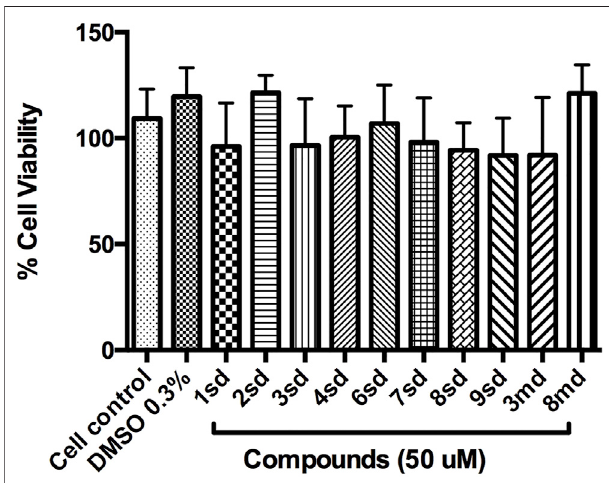
FIGURE 12 | Graph of cell viability of the compounds to 50 µM. Cell control corresponds to cells without treatment, while DMSO 0.3% corresponds to the diluent of the